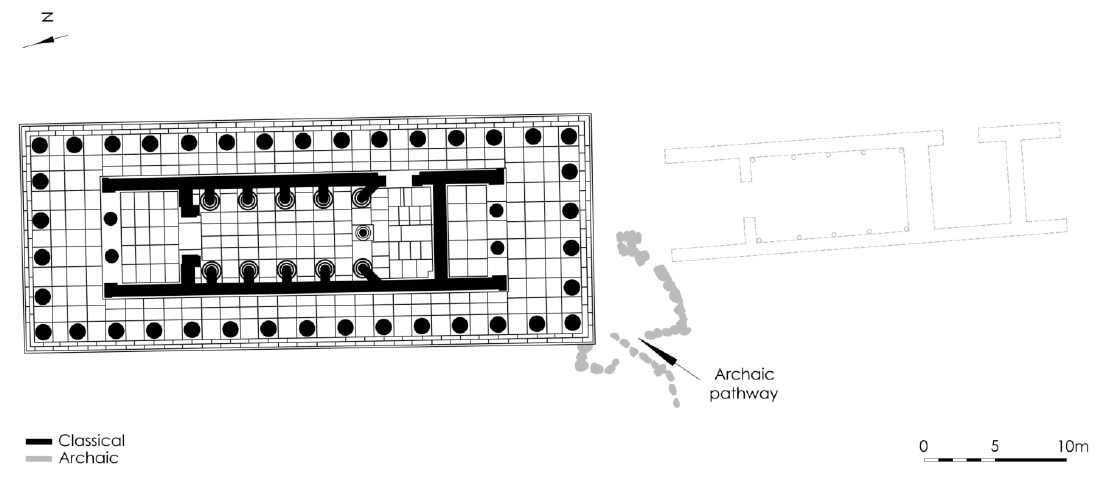
Figure 2. Ground plans of the Archaic and Classical temples of Apollo in Bassae (adapted after Kelly, 1995 by Socratis